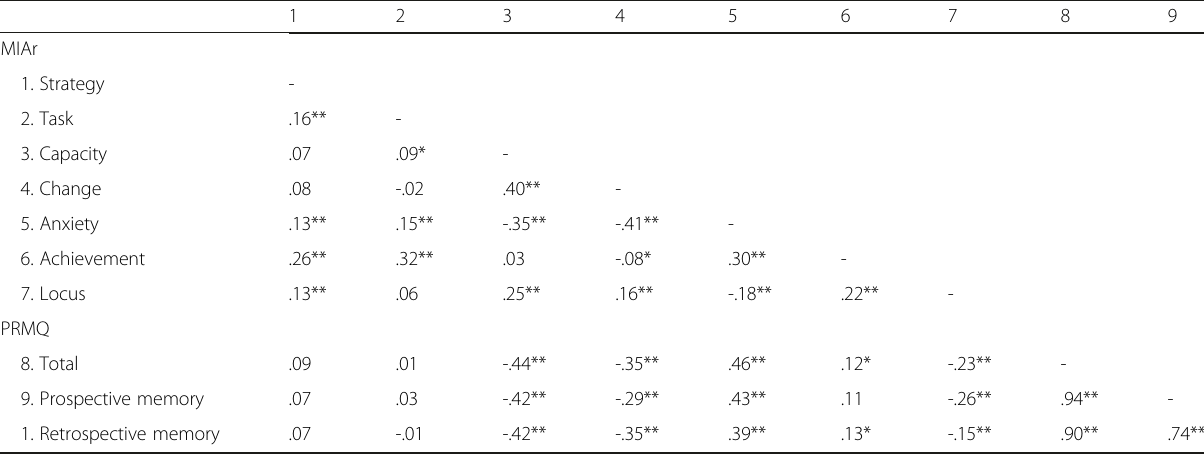
Table 3 Correlations between MIAr subscales and the prospective and retrospective memory questionnaire (PRMQ) ( n